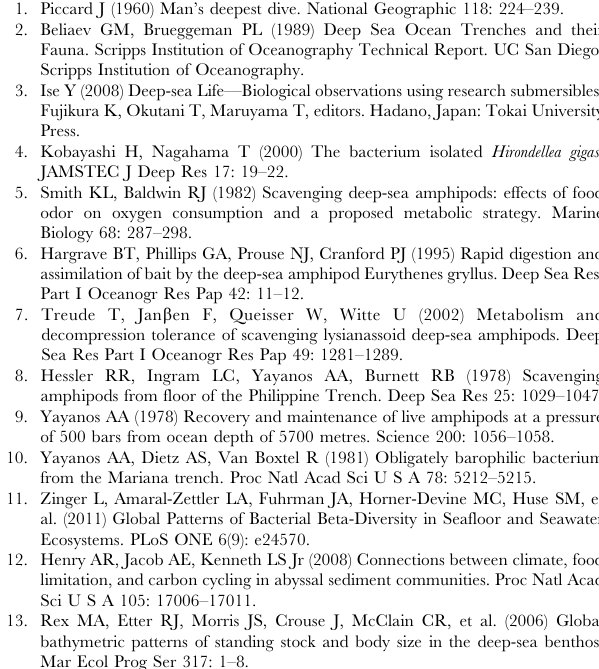
Figure S1 An 11,000 m class free-fall camera-soil sam- pling system ‘ASHURA’ (panel A) and bate traps attached to side bars (panel B). The ASHURA was equipped a camera and three cores samplers to collect soil sample. Three bait traps were attached to side bars. The bait traps contained filleted mackerel. We lowered ASHURA to the bottom of the Challenger Deep, and traced its position using sonar. Figure S2 Microscopic observation of gut contents in H. gigas . Main contents were some pieces of mackerel tissue (panel A). Arrow indicates stick-like material found in the gut of H. gigas Figure S3 Plant debris in a core sampler. Arrow indicates a peace of plant debris. There was more plant debris in another core sampler. Bar showed 5 mm. Figure S4 Final step of HGcel purification with DEAE- TOYOPEARL. HGcel was eluted from 0. 5 ml of DEAE-TOYO PEARL equilibrated with 10 mM Tris-HCl buffer (pH 8.6). HGcel was eluted sequentially with 0.2 M steps of 0–0.6 M NaCl. The volume of each elution buffer was 1.5 ml, and fraction was about 0.1 ml. Cellulase activity was measured with glucose concentration as described in Methods. No. 40 fraction contained